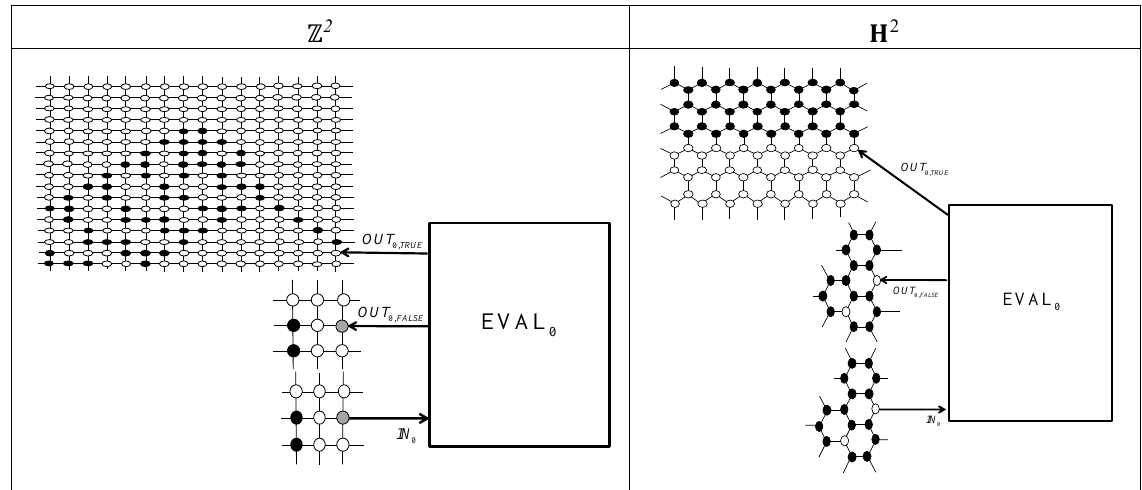
Figure 13. Reduction from QBF evaluation problem to the recognition problem of the repeatable coloring of